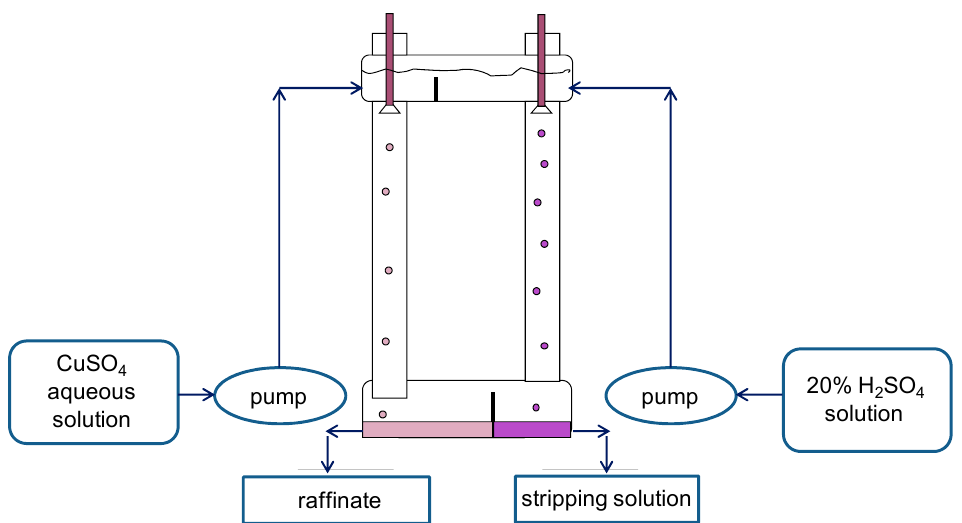
Figure 5. Scheme of the experimental setup of the large two-column extractor. Columns have a diameter of 80 mm and a height of 900 mm. To extract copper from sulfuric acid solution, 20% LIX-84 was used as an organic phase in a mixture containing 42% dodecane, 31% decane, and 27% undecane, and a 20% solution of sulfuric acid was used as a stripping phase.